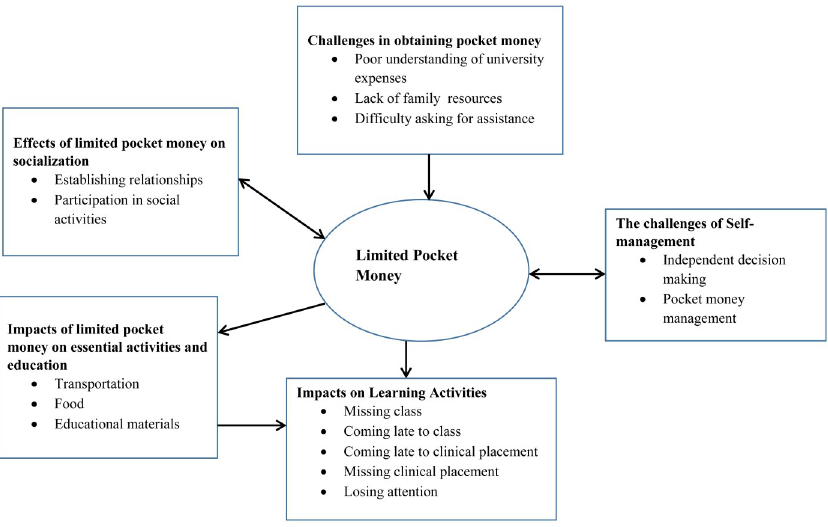
Fig 1. Conceptual framework for impacts of pocket money on learning activities: Ethiopian undergraduate health science